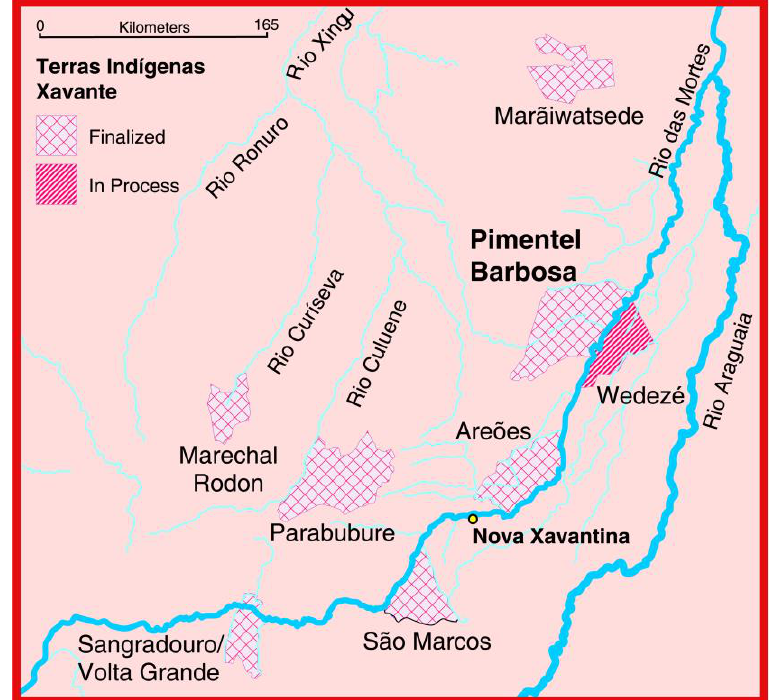
Figure 2 . Xavante indigenous territories. Source: Courtesy of Graham, Hernández and Waiassé